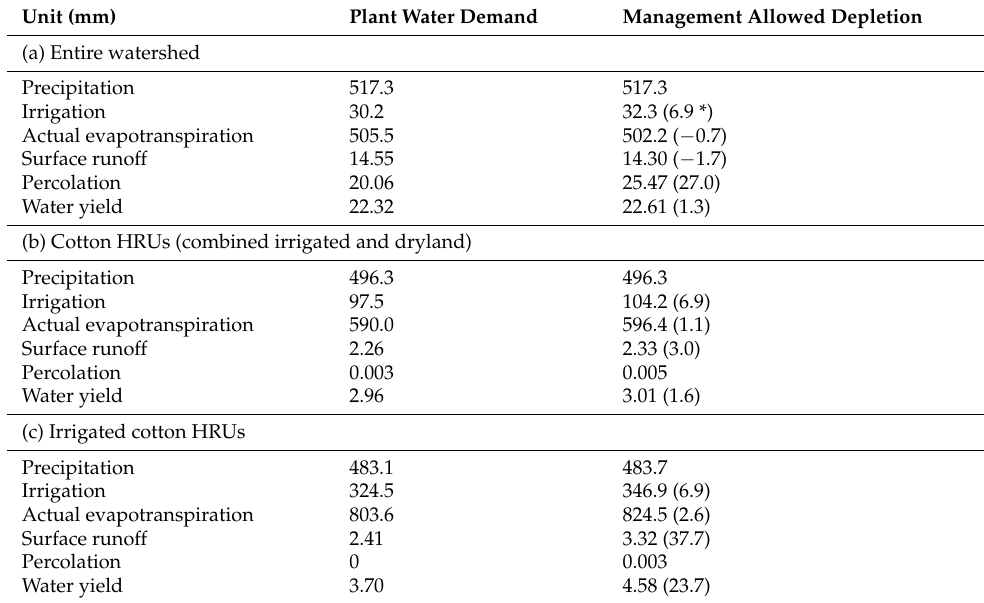
Table 3. Comparison of the average (1994–2009) annual water balance parameters using plant water demand and management allowed depletion auto-irrigation methods in the entire Double Mountain Fork Brazos watershed and cotton